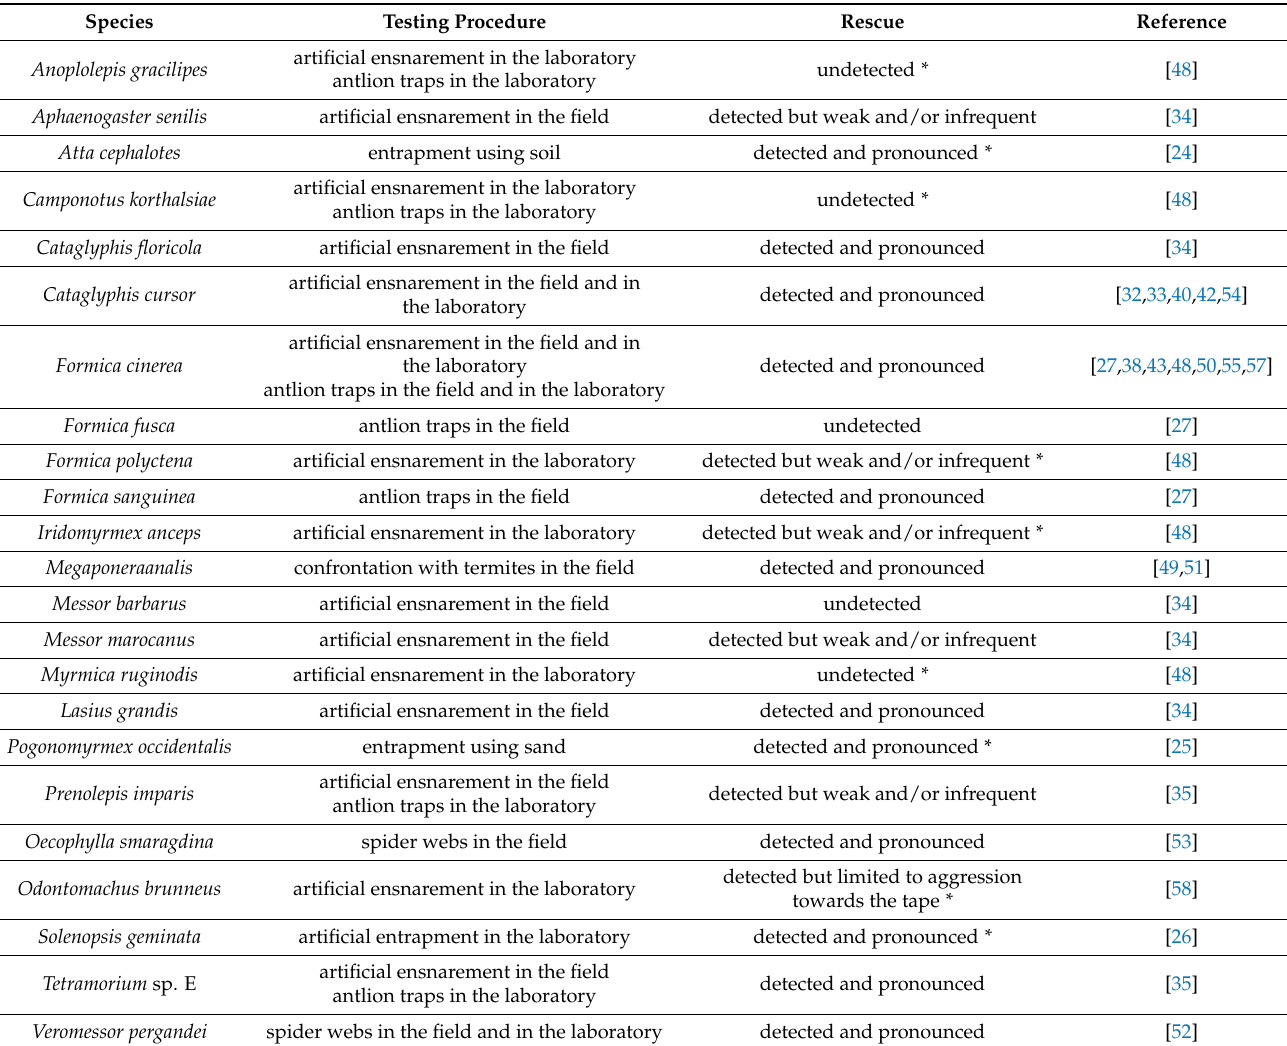
Table 1. List of ant species studied for their rescue activity. Asterisks (*) mark species with potentially somewhat underestimated activity (as suggested in [57]) in terms of, for example, frequency or behavioral categories of rescue. Species Testing